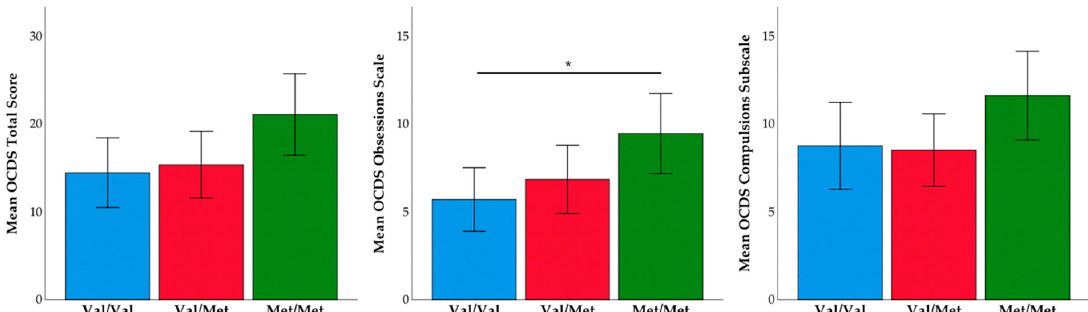
Brain Sci. 2021 , 11 , x FOR PEER REVIEW 8 of 16 − 0.31, SE = 0.13, p = 0.018, Bootstrapped CI = − 0.569 to − 0.054) and COMT genotype (b = − 2.35, SE = 1.05, p = 0.025, Bootstrapped CI = − 4.4 to − 0.29) independently predicted re- lapse, as well as their interaction (b = 0.11, SE = 0.05, p = 0.024, Bootstrapped CI = 0.015 to